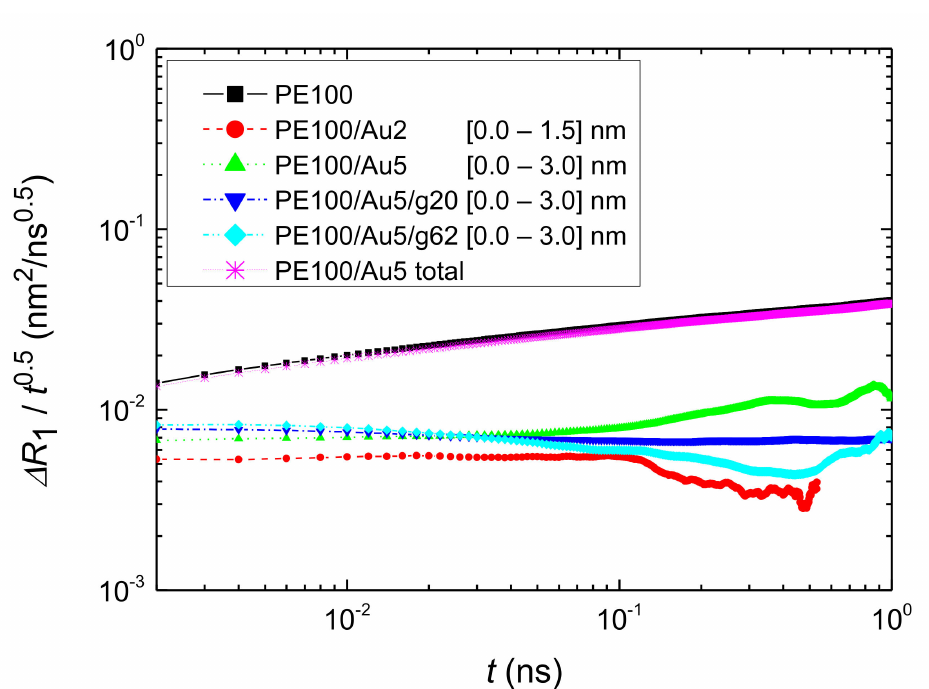
Figure 11. Segmental MSD of PE chains for the first adsorption spherical shell, ∆ R 1 , scaled with t 0.5 . Data for the PE100/Au2, PE100/Au5, PE100/Au5/g20 and PE100/Au5/g62 systems are shown, together with data about the MSD of the entire PE100 and PE100/Au5